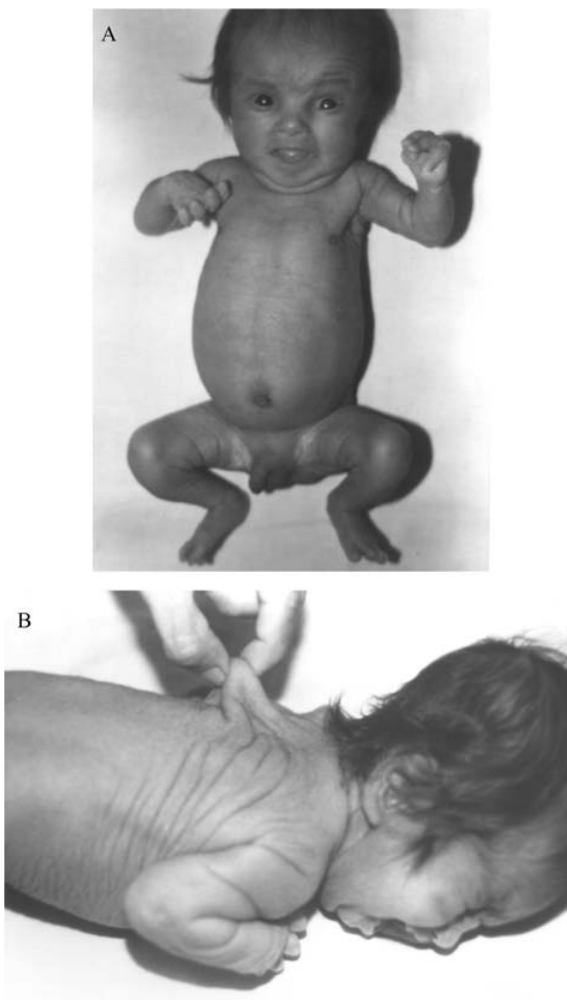
Figure1 -Patient1at4monthsofage.Notethesenileappearanceandab- normal position of the hands (A) and hyperextensible skin on the dor- sum